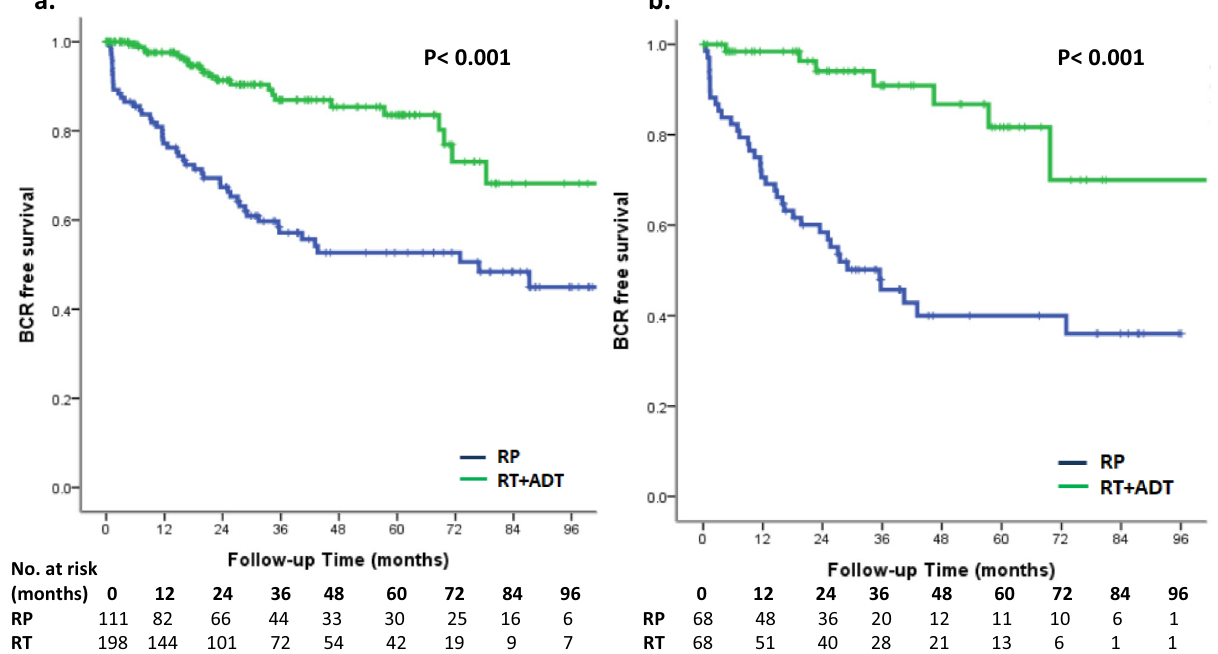
Figure 1. Kaplan–Meier analysis of biochemical recurrence free survival in ( a ) all cohort patients and ( b ) propensity-score matched patients. For each treatment group, we generated Kaplan–Meier survival curves for biochemical recurrence (BCR) according to management method, and calculated a log-rank test to evaluate the association of BCR with different management method. We also compared the BCR free survival between all cohort patients and propensity-score matched patients.